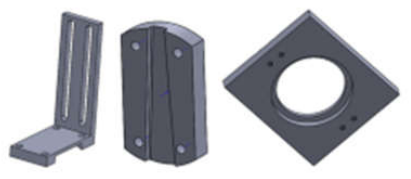
Figure 14. Universal testing machine EDZ20.